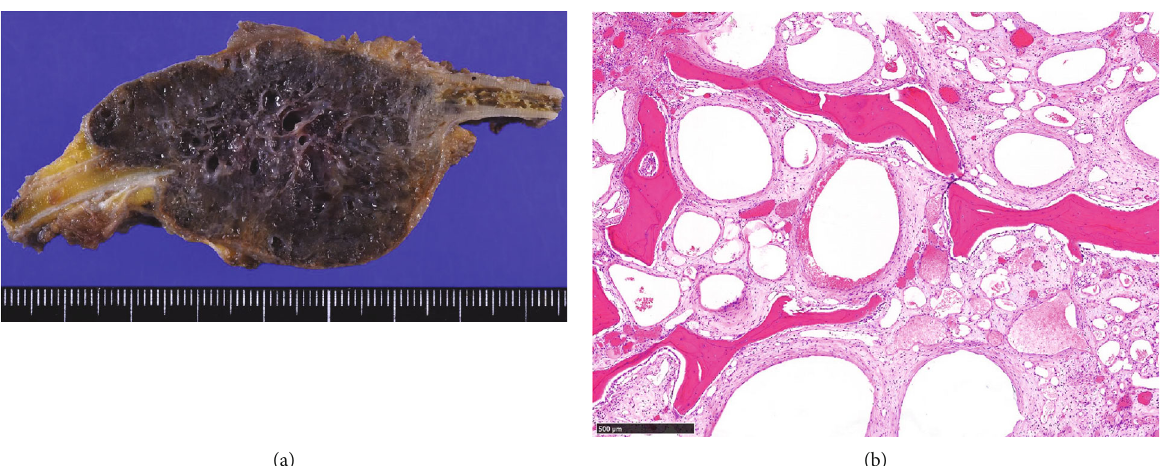
Figure 3: (a) Gross appearance of the resected specimen. Numerous vessels were identi fi ed. (b) The histopathology of the lesion showed that the tumor was comprised of numerous irregular, dilated, and thin-walled vessels lined with a single layer of fl attened endothelial cells, without cytologic atypia, consistent with the fi ndings of hemangioma. The coarse trabecular bones were observed.